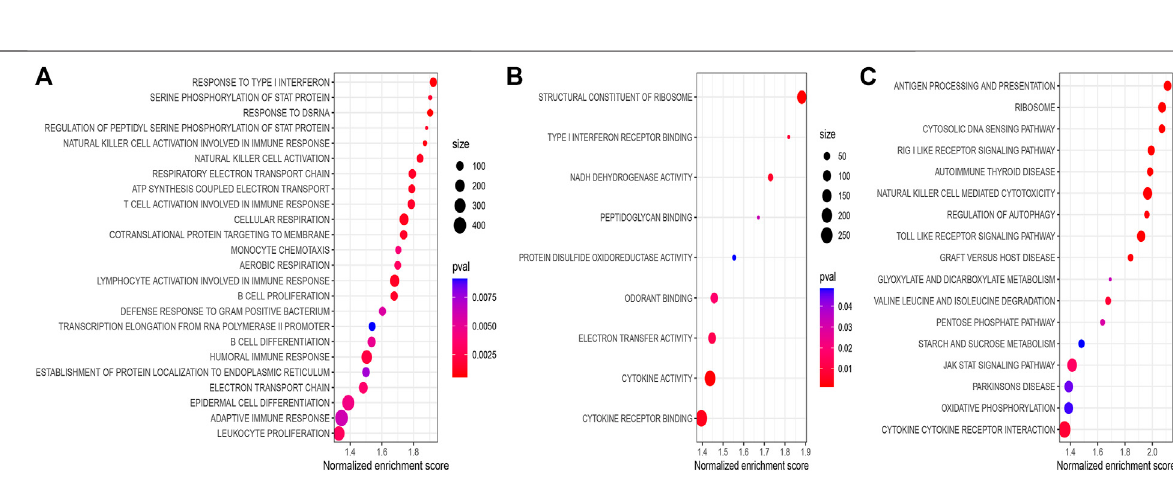
Frontiers in Molecular Biosciences |